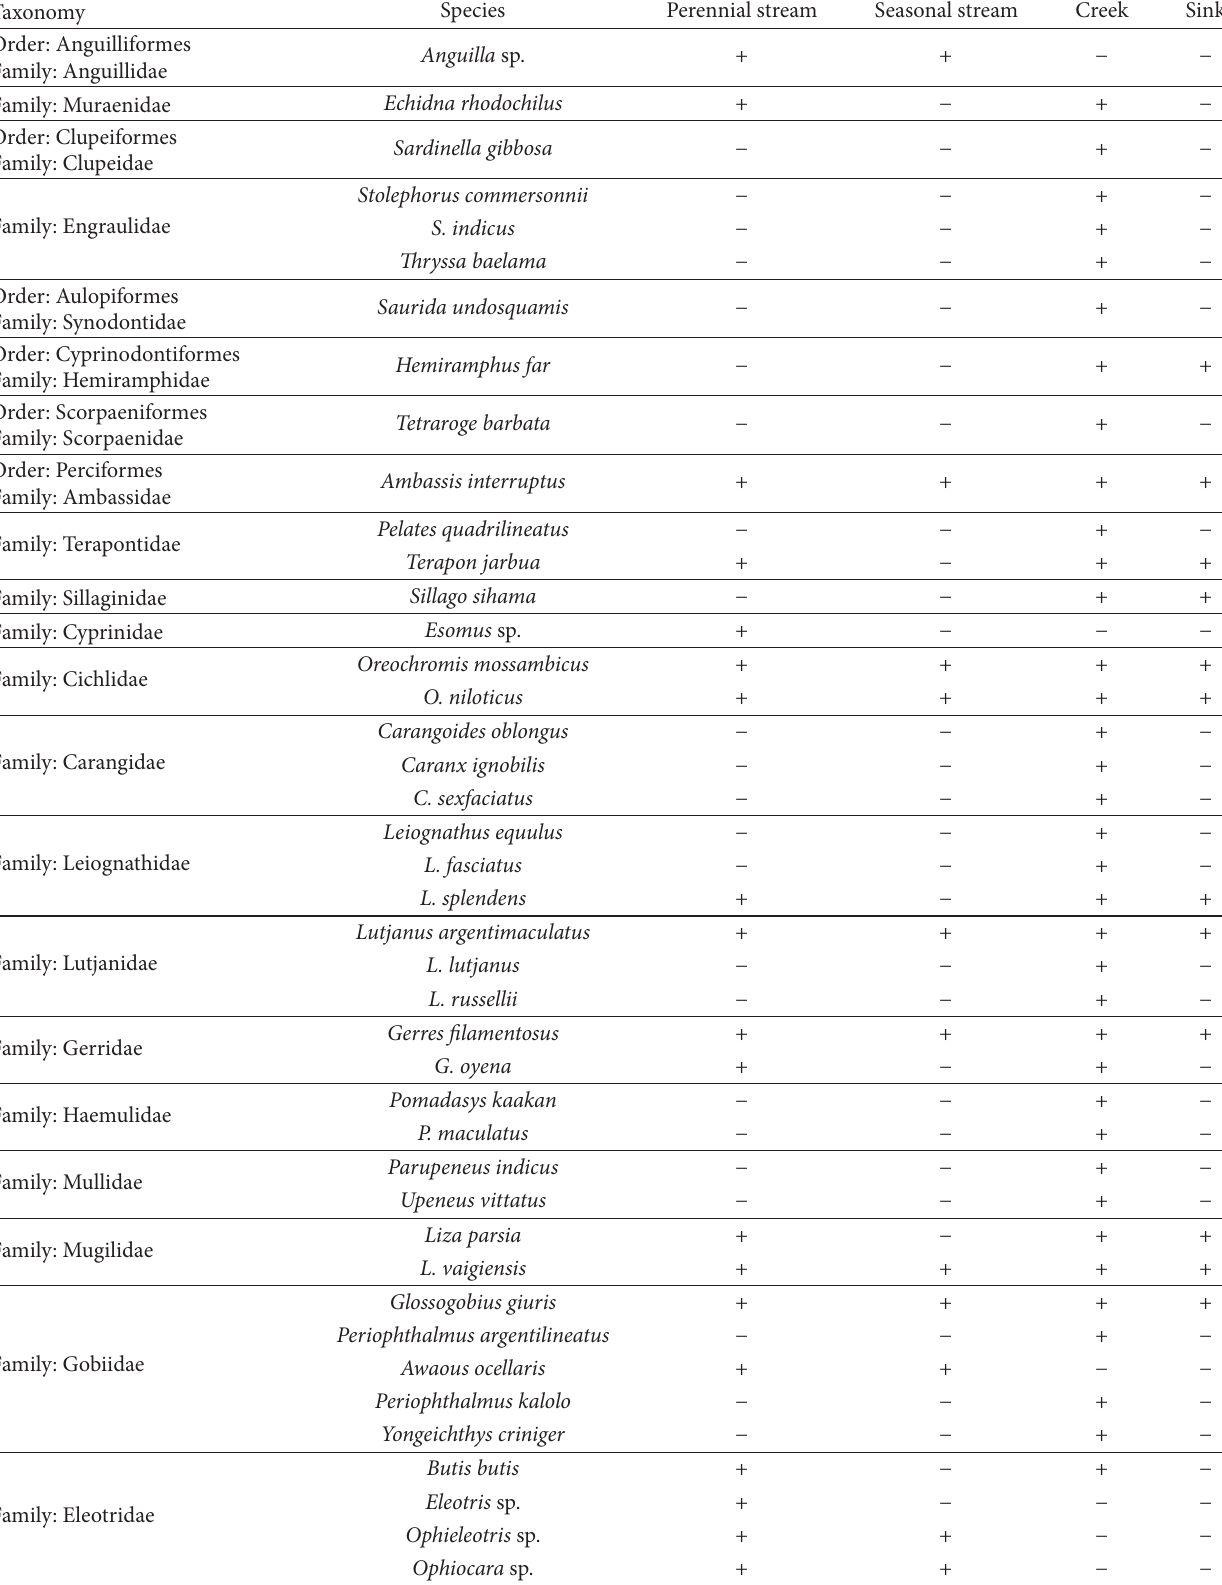
Table 6: Species composition of fishes in the study